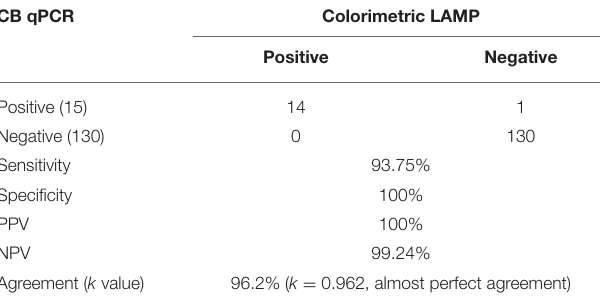
TABLE 2 | Performance of colorimetric loop-mediated isothermal amplification (LAMP) for clinical sheep vaginal swabs ( n = 145) compared to reference CB qPCR